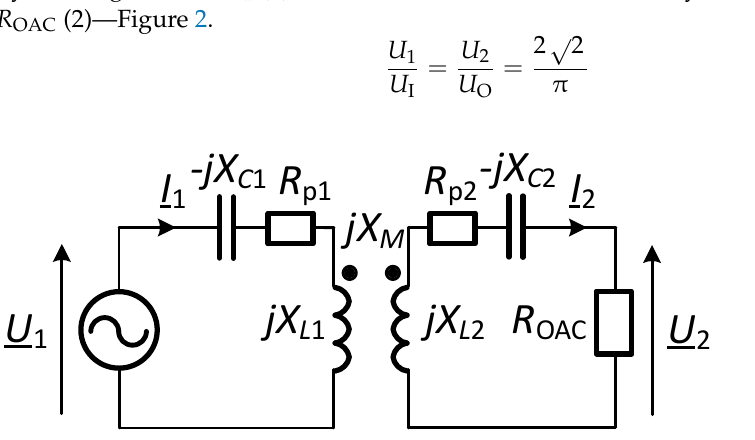
Figure 3. Schematic of MCR